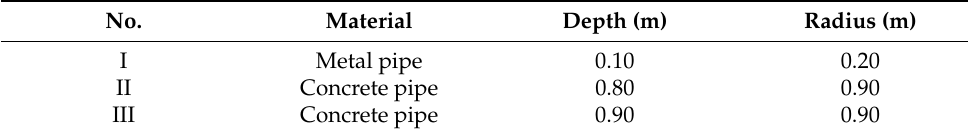
Table 3. Experimental physical models’ parameters—data sheet.